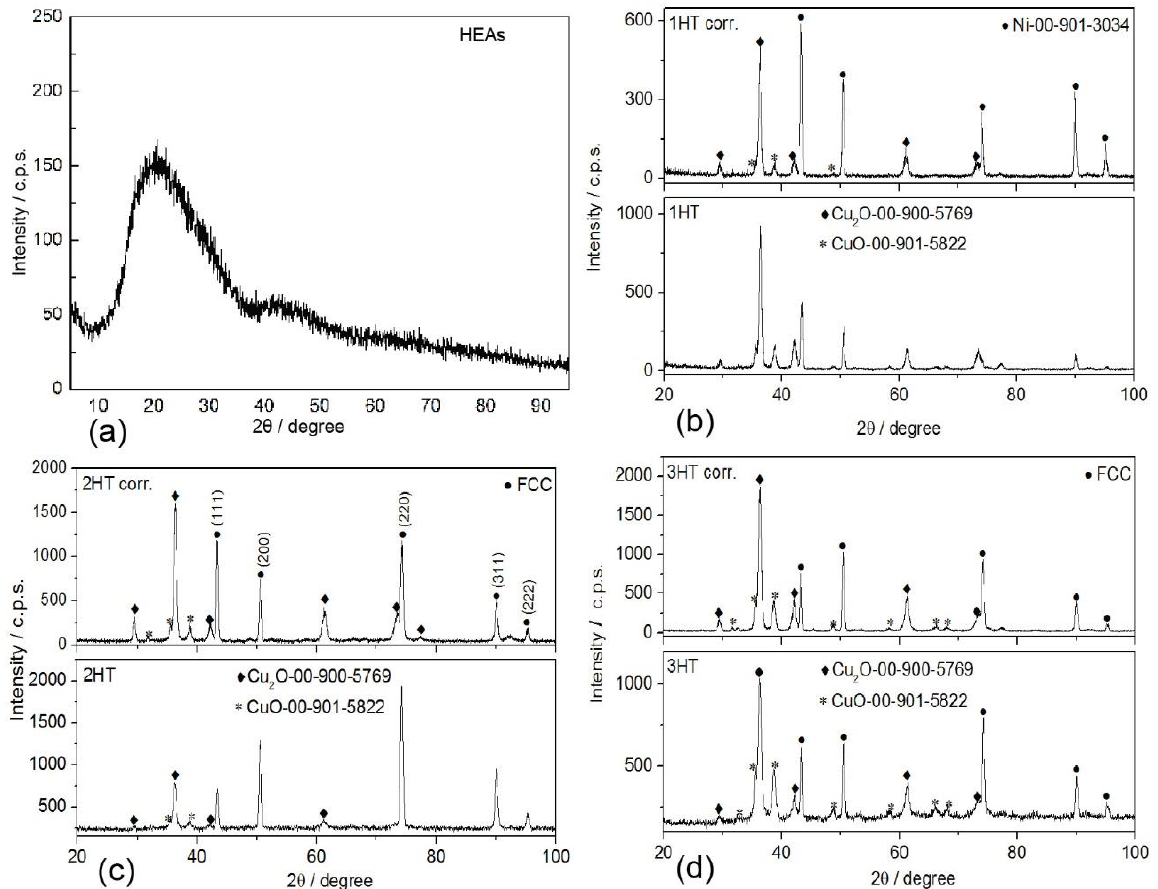
Figure 8. XRD patterns obtained on the HEA CoCrFeMnNi thin films: ( a ) as-deposited; ( b – d ) heat-treated and corroded.